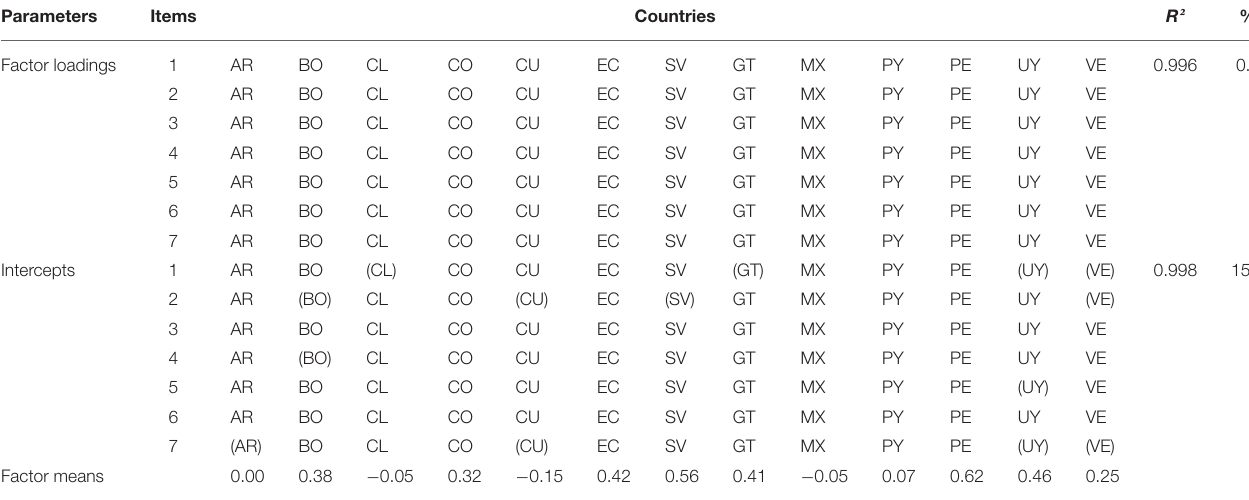
TABLE 6 | Approximate measurement invariance of the COVID-VCBS using the alignment method. Parameters Items Factor loadings